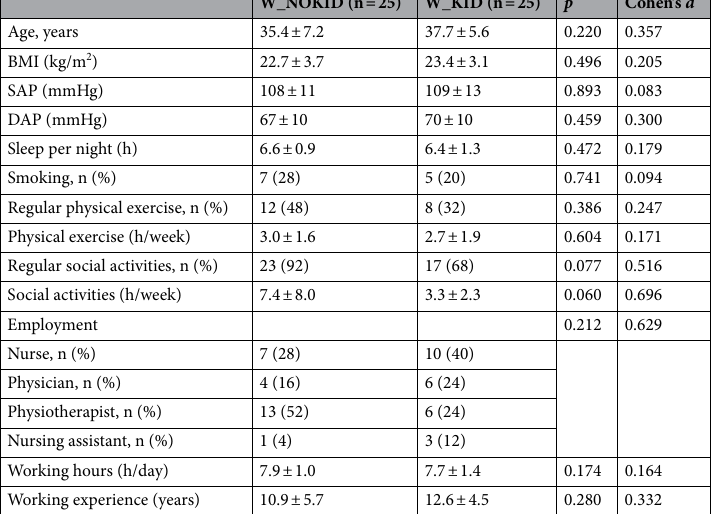
Table 1. Ten women were on birth control pills (6 in W_NOKID and 4 in W_KID). No other regular medications were declared. As regards W_KID, an only child was present in 48% of cases, 2 children in 52% of cases. The mean age of children was 33.6 ± 18.1 months. The number of holidays and shifts was similar for W_KID and for W_NOKID. The percentage of subjects performing regular exercise (at least 1 day/week for at least 4 weeks) was also homogenous in the two groups, as well as the amount of sleeping hours per night.